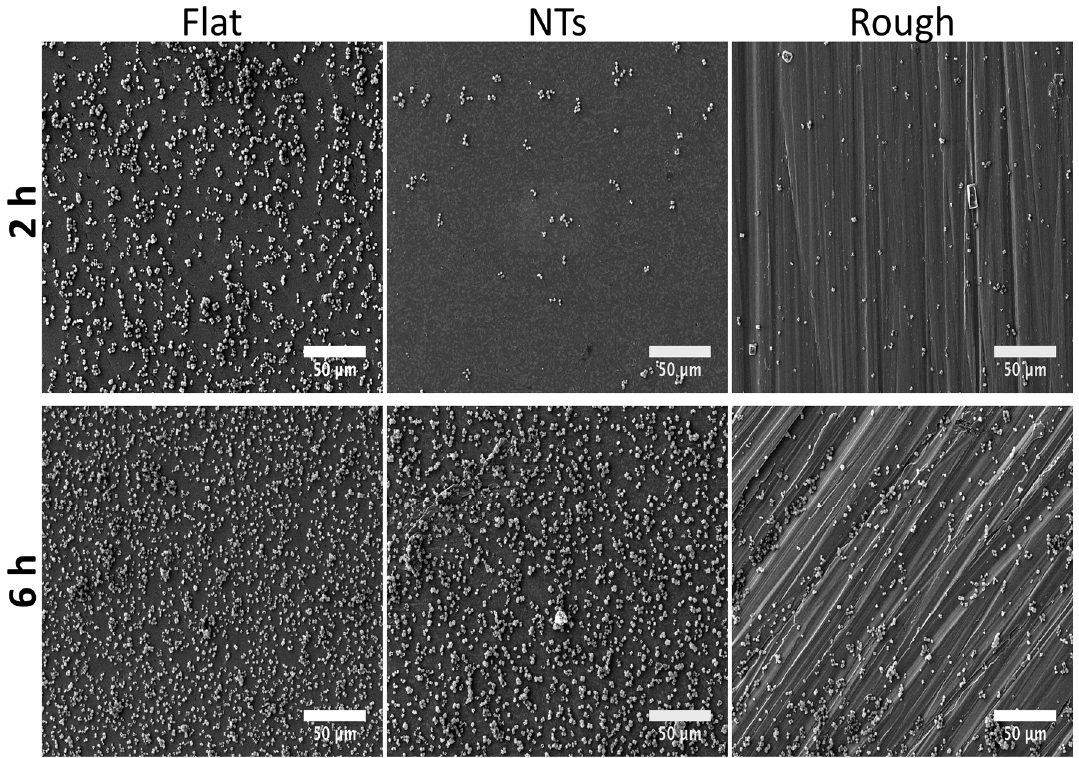
Figure 3. Initial and late colonization behavior of S. epidermidis over the experimental specimens as a function of time. A superior number of S. epidermidis can be highlighted over the flat surface at all incubation times.